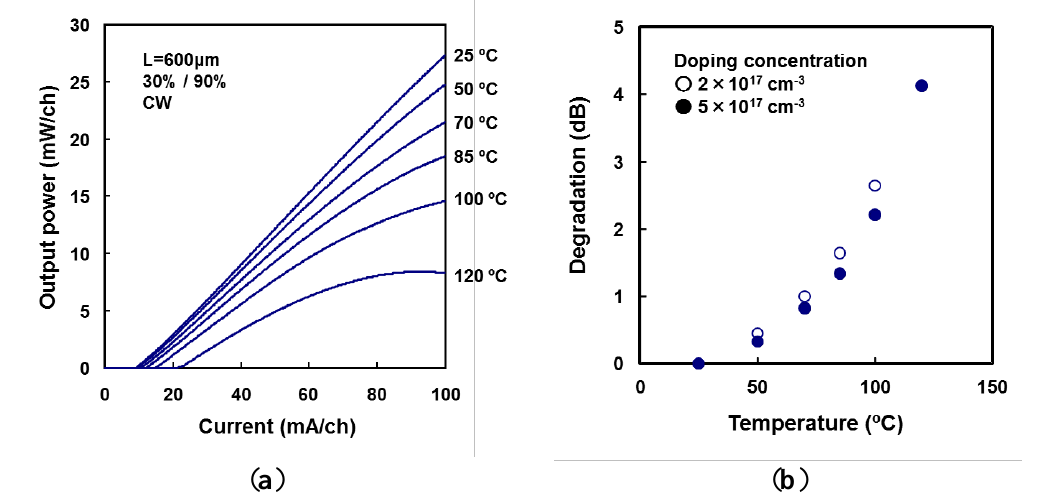
Figure 3. Light output characteristics. ( a ) Temperature dependence. ( b ) p-type doping concentration